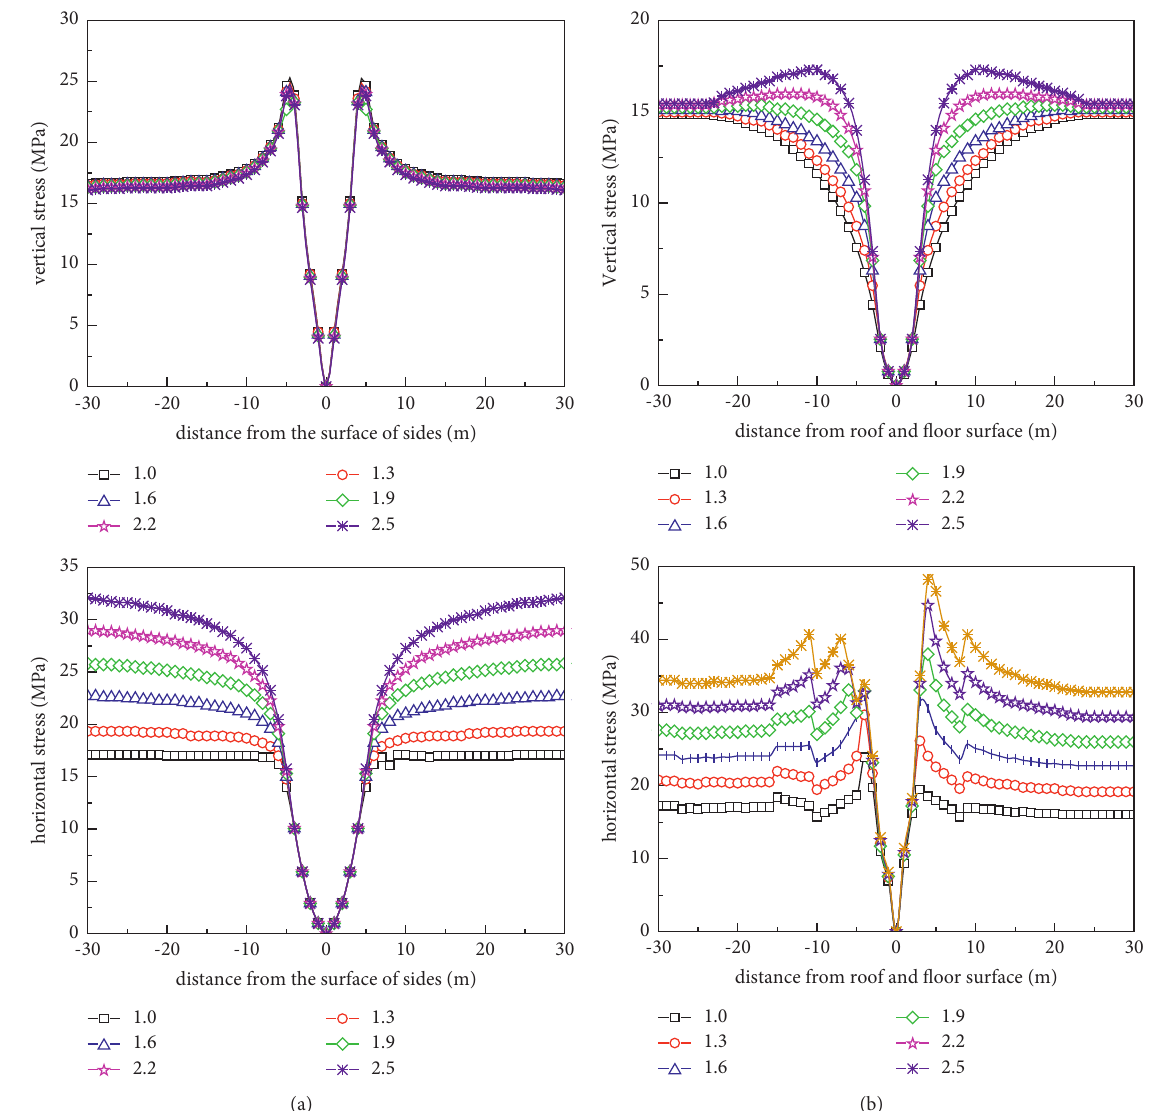
Figure 11: Stress distribution of roadway surrounding rock. (a) Sides; (b) roof and